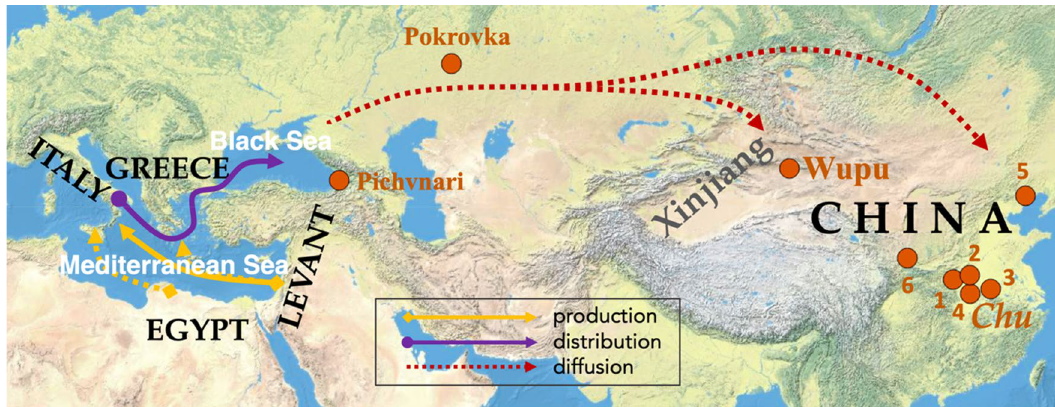
Figure 3. The three-segment ‘life history’ model for the dispersed natron glasses. Production (yellow line): raw glass was shipped from the Levant to workshops across the Mediterranean for secondary production, with one likely route for Type II glass indicated by the solid line. Egypt also provided raw glass but not likely for the products traveling to eastern Eurasia. Distribution (purple line): finished glass products were traded in the Mediterranean and the Black Sea regions as Greek colonization intensified. Diffusion (red line): small glass jewelry was carried by nomadic groups while traveling across the Eurasian Steppe, who essentially facilitated the eastward flow of natron glass. Indicated routes are not meant to be exact. Sites to the east of the Black Sea where natron glass dated to the mid-1st millennium BCE have been found are marked by orange dots. Chinese sites with early natron glass: central (Chu state): 1 Xujialing, 2 Jiuxian, 3 Hougudui, and 4 Zenghouyi/Leigudun; north: 5 Jianchang; west: Wupu and 6 Majiayuan. This map was created with QGIS 3.10 (https ://qgis.org), based on the basemap of World Physical Map (http://goto.arcgi sonli ne.com/maps/World _Physi